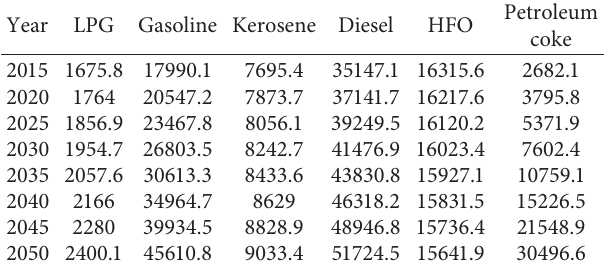
Table 1: Present and predicted production of crude oil derivatives from refineries in Saudi Arabia (hundred million barrels). LPG Gasoline Kerosene Diesel HFO